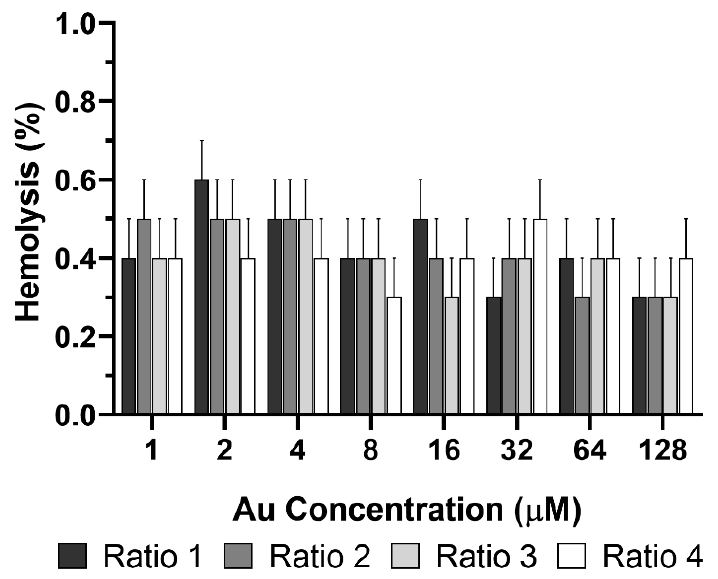
Figure 13. Hemolytic activity of different types of AuNPs (Ratio 1, Ratio 2, Ratio 3 and Ratio 4 AuNPs). PBS 1× (pH 7.4, USP32) and MilliQ water were used as negative and positive controls, respectively. Results represent the mean value ± SD, n ≥ 3.